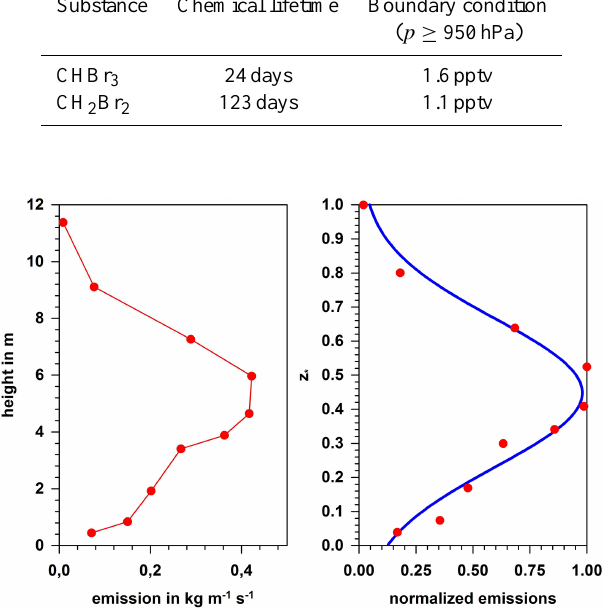
Figure 1. (a) Vertical profile of the emissions given in Stohl et al. (2011). (b) Normalized emission profiles. The blue line gives the fit with a Gaussian